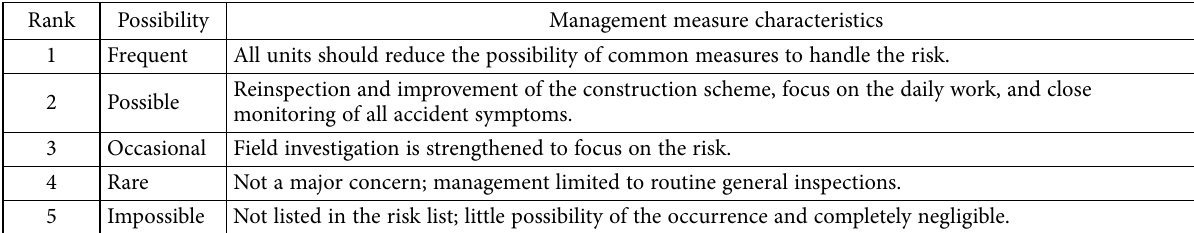
Table 5. Risk occurrence probability level judgment standard